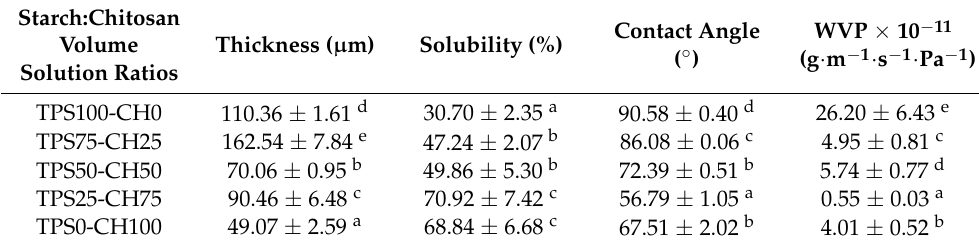
Table 1. Thickness, water solubility, and water-vapor permeability of thermoplastic modified corn- starch and chitosan composite